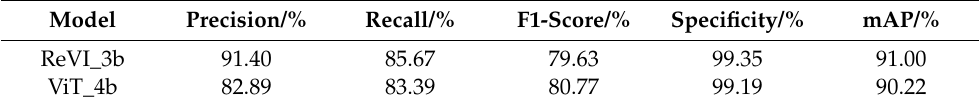
Table 3. Average precision, recall, F1-score, specificity and mAP of ViT_4b and ReVI_3b.